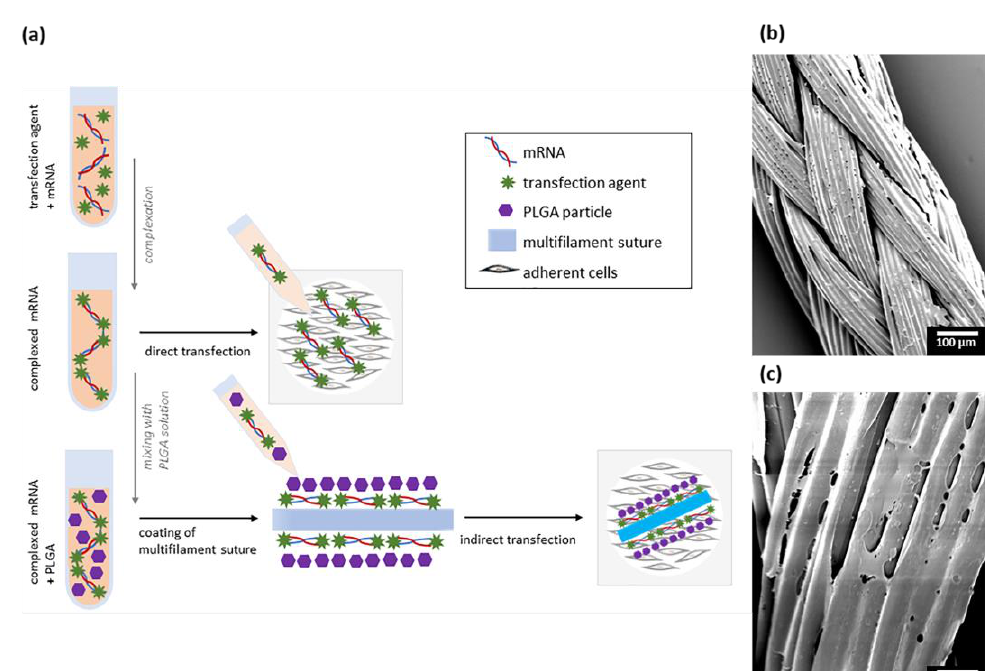
Figure 1. Schematic overview of the coating process and microscopic view of the coating . After complexation of a specific mRNA, cells can either be transfected in a direct manner or the complexed mRNA can be mixed with a PLGA solution followed by coating of multifilament sutures and subsequent indirect transfection ( a ). Scanning electron microscope visualization of the surface of the mRNA-PLGA coated multifilament suture in 100-fold ( b ) and 500-fold ( c ) magnification. In order to evaluate whether Viromer RED or Lipofectamine 2000 is more suitable to build a functional mRNA-PLGA coating, HEK293 cells were transfected with 1 µg eGFP mRNA either by